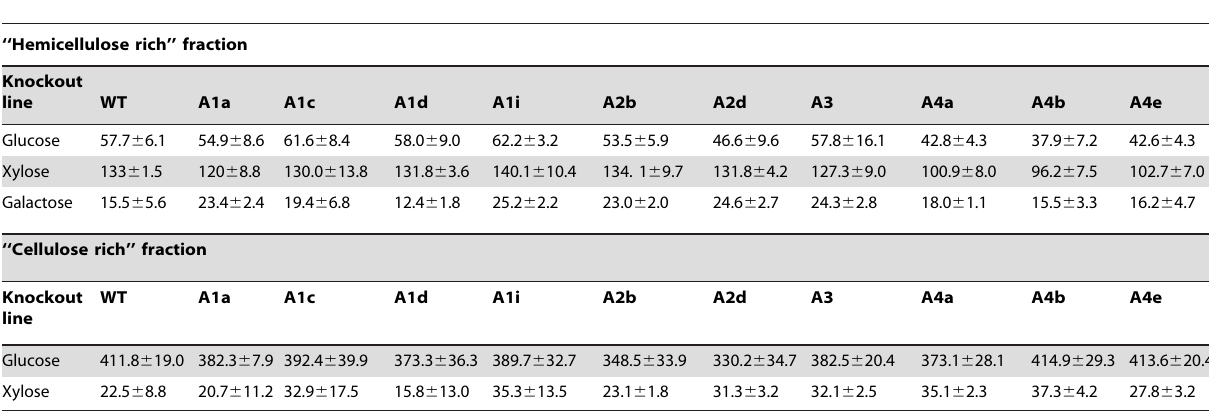
Table 1. Sugar composition of the ‘‘hemicellulose rich’’ and ‘‘cellulose rich’’ fractions expressed as mg/g AIS.